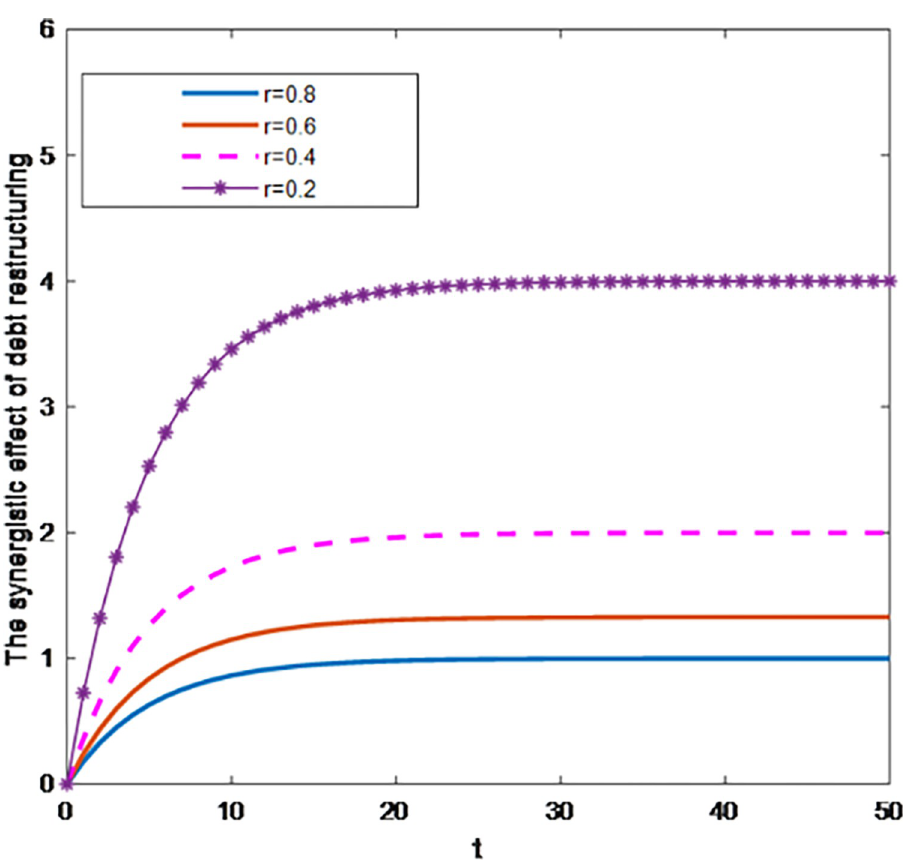
Fig 5. Influence of parameter r on the synergistic effect of debt